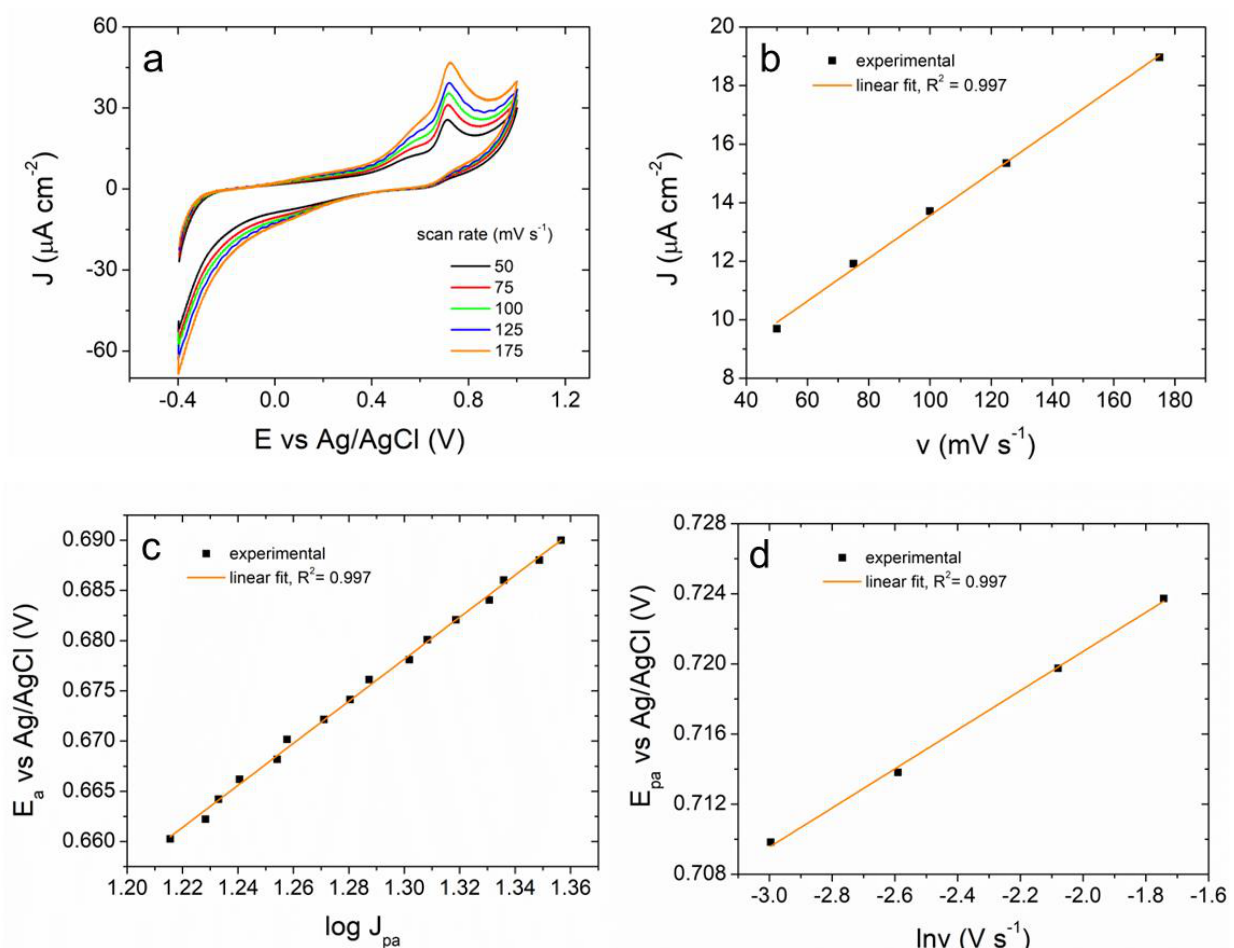
Figure 3. ( a ) Cyclic voltammograms of ACP (20 µ M) in sodium acetate buffer (0.1 M, pH 3) registered with the ITO/(NiTsPc/CeO 2 )-10 electrode at different scan rates (50–175 mV s − 1 ). ( b ) Dependence of the oxidation current density (J pa ) on the scan rate, ( c ) Tafel plot of the ACP oxidation peak at 50 mV s − 1 , and ( d ) dependence of the peak potential ( E pa ) on ln v . The slope of the straight line is equal to [RT/2 α nF], in which n is the number of transferred electrons. Once α is known, n can be calculated. The value found was 1.61